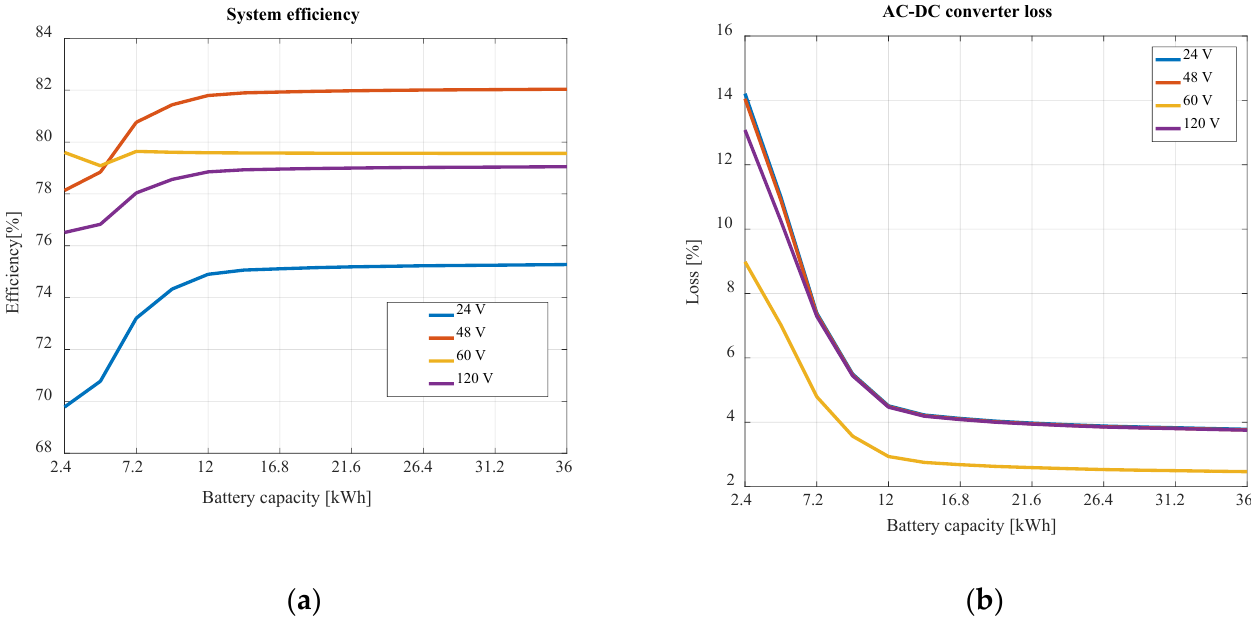
Figure 10. Efficiency of DC-RNG and AC–DC converter loss by sweeping battery capacity: ( a ) DC-RNG efficiencies, ( b ) AC–DC converter loss.